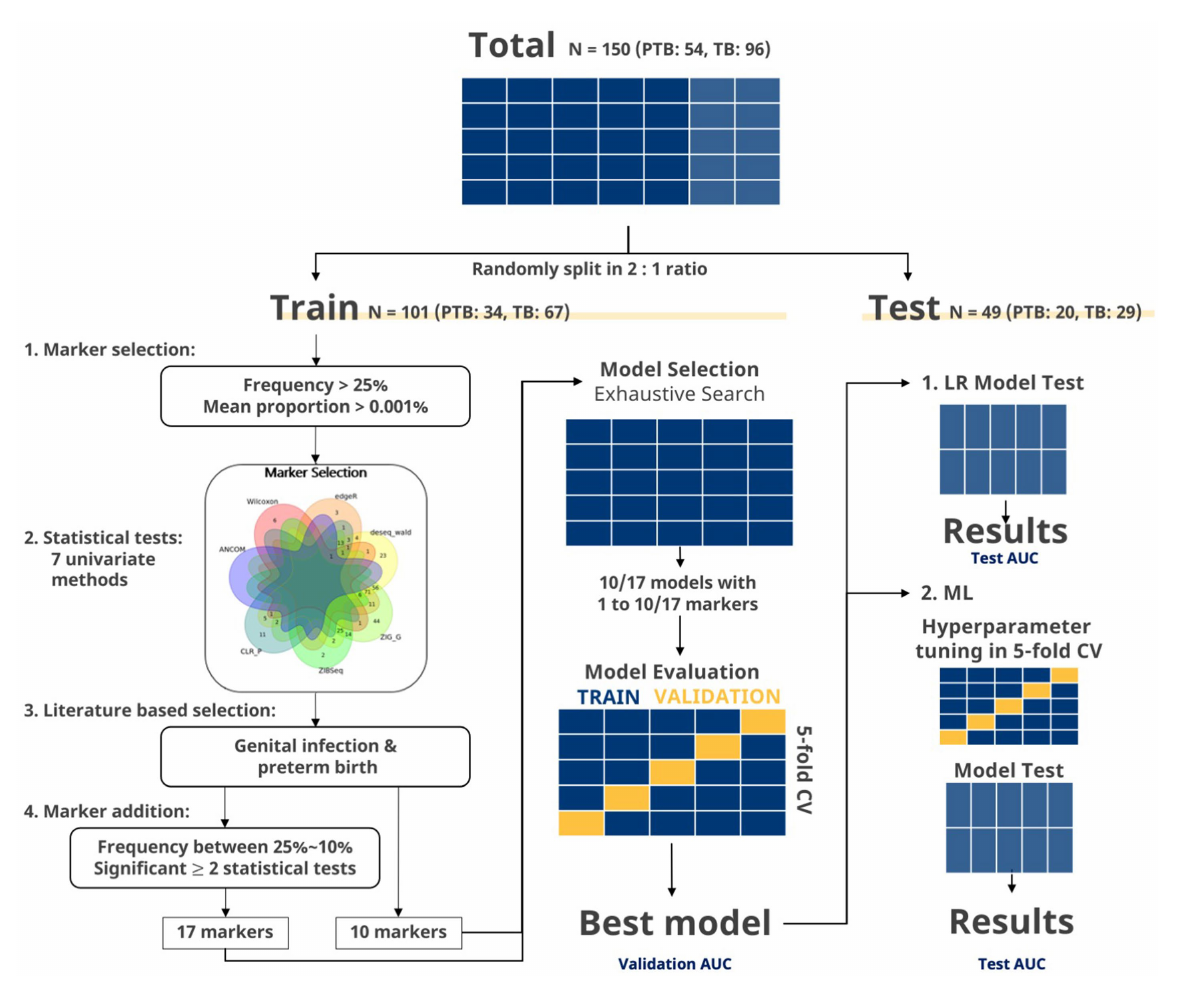
FIGURE 2 Flowchart of marker selection and evaluation in exhaustive search. The data were split to a training set and test set in a two-to-one ratio. Markers with frequency more than 25% and mean proportion more than 0.001% were selected. Then, markers, showing significant p values in two or more statistical tests, were selected. Venn diagram of significant markers ( p < 0.05) after seven statistical methods (ZIG, ZIBSeq, ANCOM, CLR permutation, Wilcoxon rank-sum test, DESeq2, and edgeR) is shown. Additional filtering steps were applied to the selected markers to finalize the set of 10 and 17 markers. For the given set of markers, exhaustive search was applied to every possible combination of markers using LR. Best marker sets for each number of combinations were selected using AUC from the training set. The global best marker set among these selected sets was chosen as the one that showed the highest AUC from the five-fold CV. Then, the final marker set was select based on the test set. Lastly, the final marker sets were used in building machine learning (ML)